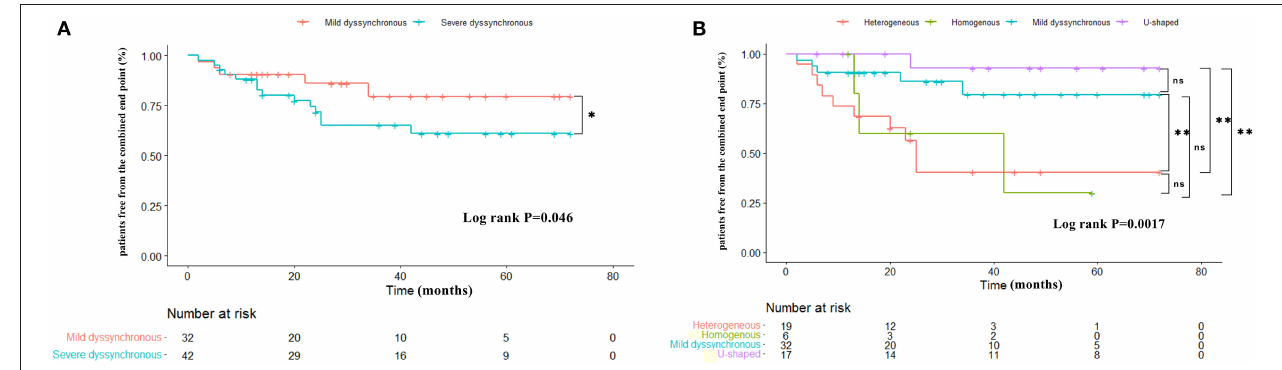
FIGURE 5 | Kaplan-Meier curves comparing survival free of the combined end point in different groups. (A) The mild dyssynchronous group demonstrated a better long-term prognosis than the severe dyssynchronous group. (B) The incidence of HF hospitalization or all-cause mortality is significantly lower in the mild dyssynchronous group than in the heterogeneous group, which was similar to the U-shaped group. Log-rank P : * P < 0.05, ** P < 0.01. ns, no statistically